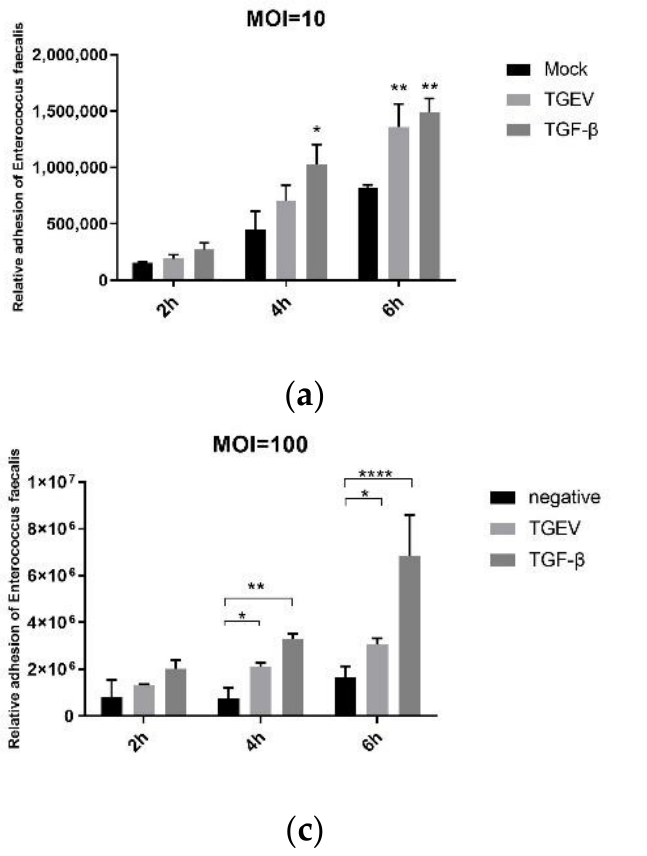
Figure 8. Adhesion of E. faecalis to IPEC-J2 cells at different infection rates and time points. ( a ) MOI = 10; ( b ) MOI = 50; ( c ) MOI = 100. * p < 0.05, ** p < 0.01, *** p < 0.001, **** p < 0.0001